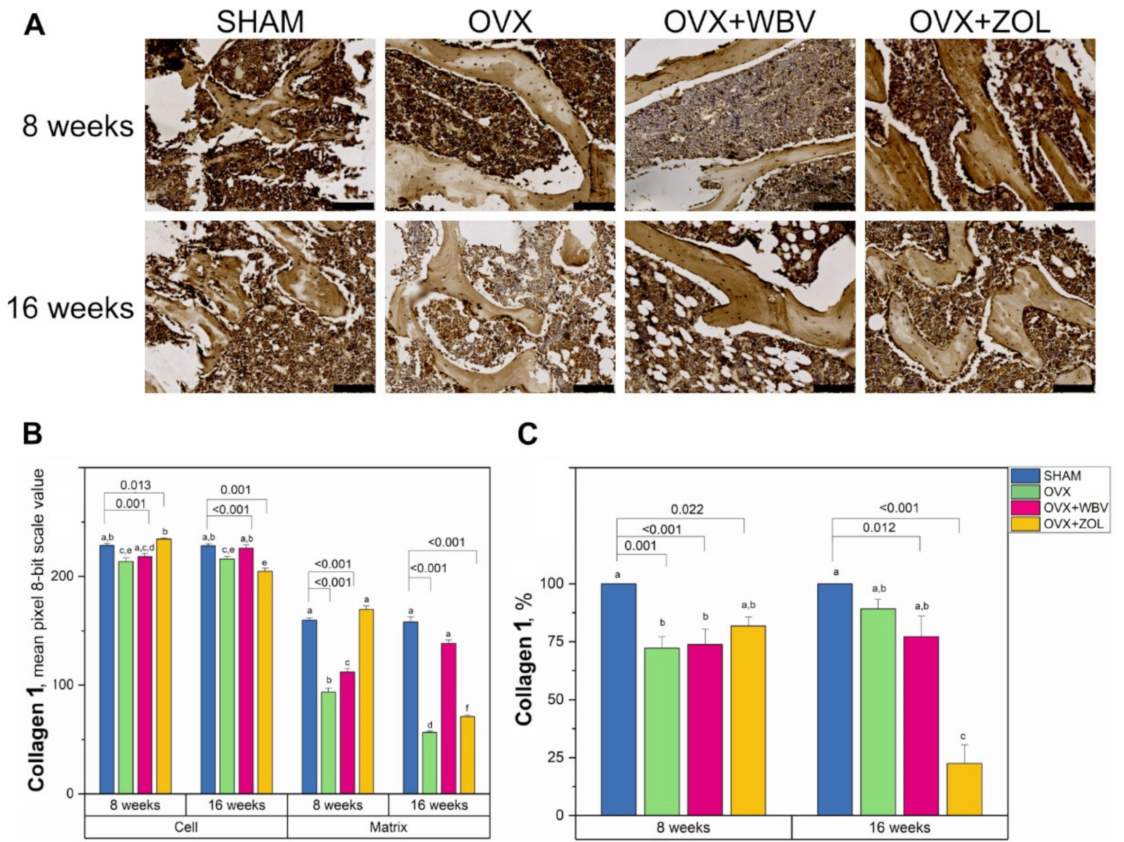
Figure 3. ( A ) Representative images of the immunohistochemical reactions for collagen 1 (Col1) in the trabecular bone of femora from controls (SHAM surgery), ovariectomized rats (OVX), ovariectomized rats with whole body vibration (OVX + WBV), or Zoledronic acid (OVX + ZOL). All the scale bars represent 100 µ m. ( B ) Bar graphs show the intensity of expression of Col1 in cells (osteocytes) and matrix measured by the comparison of the pixel brightness value in the microscopic images converted to 8-bit grayscale—the higher the pixel value, the higher the intensity of the immunohistochemical reaction. ( C ) The percentage of cells with a positive response. Data are presented as mean ± SE with corresponding statistical analysis. Statistically significant differences between groups (at p < 0.05) are indicated by a, b, c, d, e, and f letters. Dunnett post-hoc significant p -values are placed over